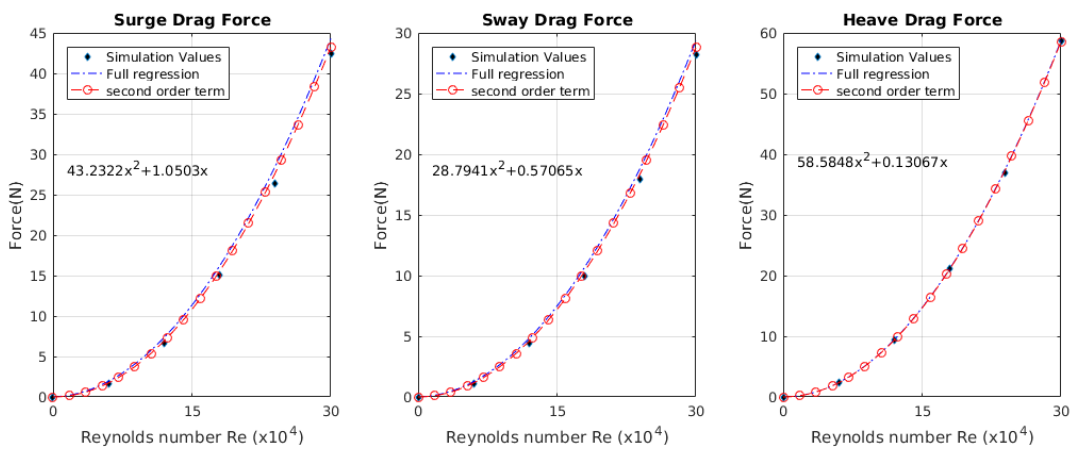
Figure 16. The values of the regressions obtained for the X, Y and Z axes, in terms of their surge, sway, and heave speeds, respectively. The black diamonds are the values obtained using the CFD simulation, the regression with all the terms is the dotted blue line and the red line shows the model using just the quadratic